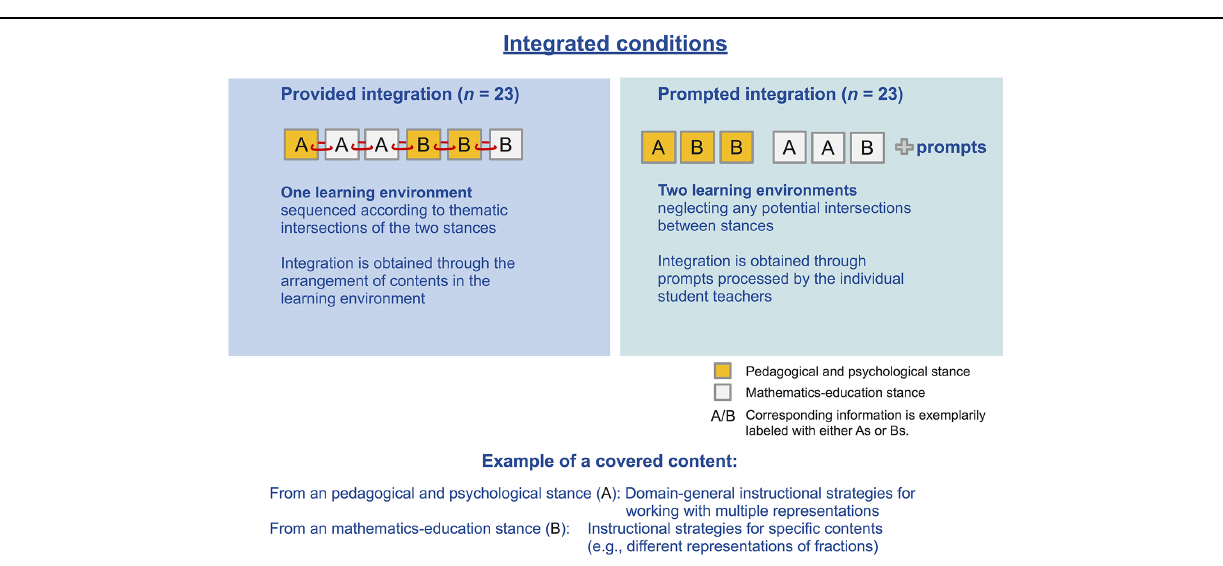
FIGURE 2 | Illustration of how integration of contents was achieved in the different integration